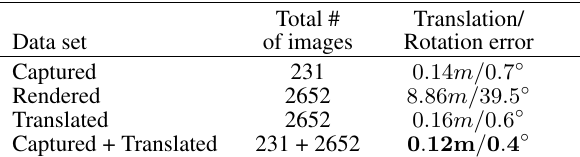
Table 3. Median translation and rotation test errors on the cap- tured, rendered and translated data sets. We also trained a model on a combined data set of captured and translated images scor- ing the best